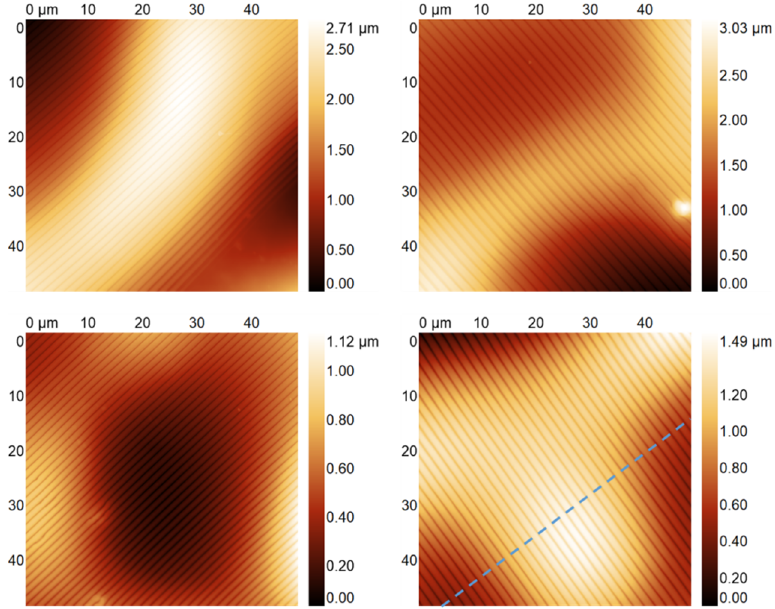
Figure 6. AFM images of the hierarchical structures master used for further imprinting. The left and right images have line and space dimensions of 300 nm/900 nm and 400 nm/1200 nm, respectively. The dashed line in the lower right corner indicates the location of the extracted linescan shown in Figure